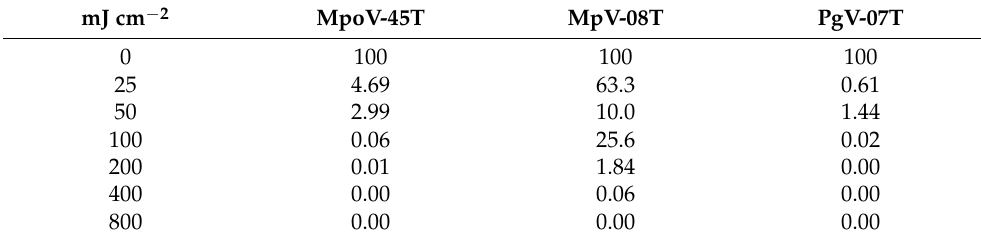
Table 1. Average virus production rates ( n = 2, average ± SD except for PAR-only controls (0 h UV) in experiment 1 where n = 1). Table 2. Average infectivity of 3 different marine viruses (1 polar, 2 temperate) after different UV-C doses. Infectivity is expressed as % of control. Infectivities at 0 UV-C were 100, 83 and 72% for